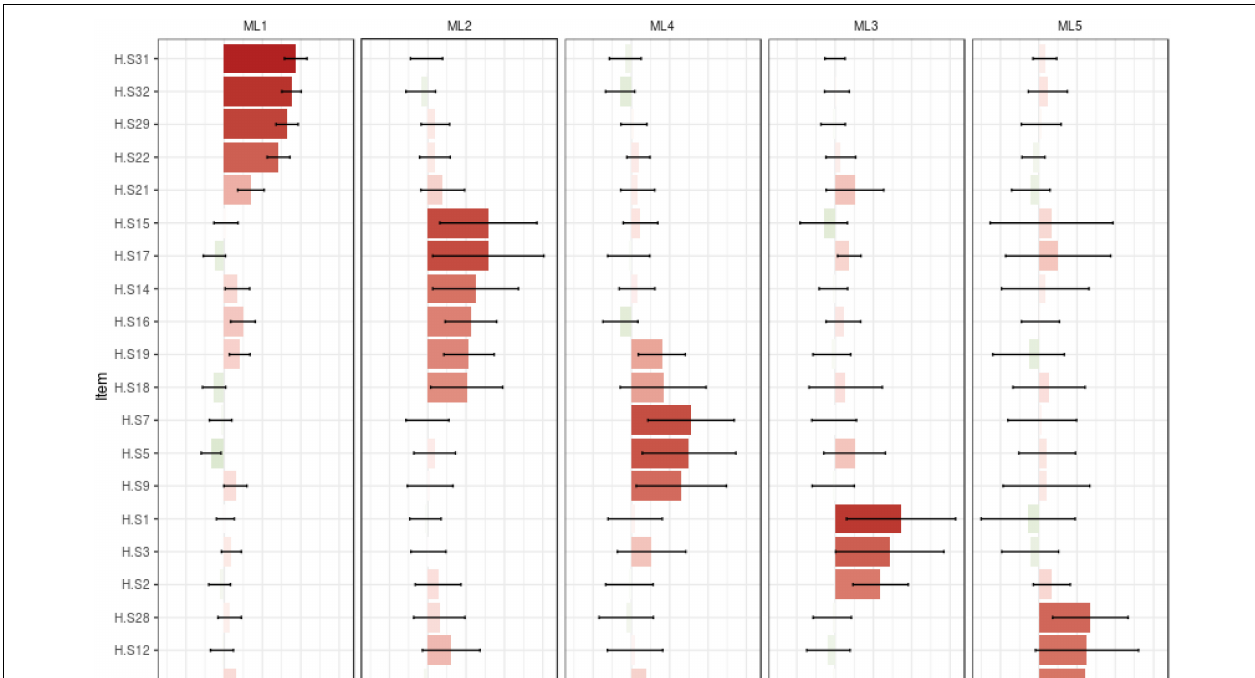
FIGURE 2 | Exploratory graph analysis.